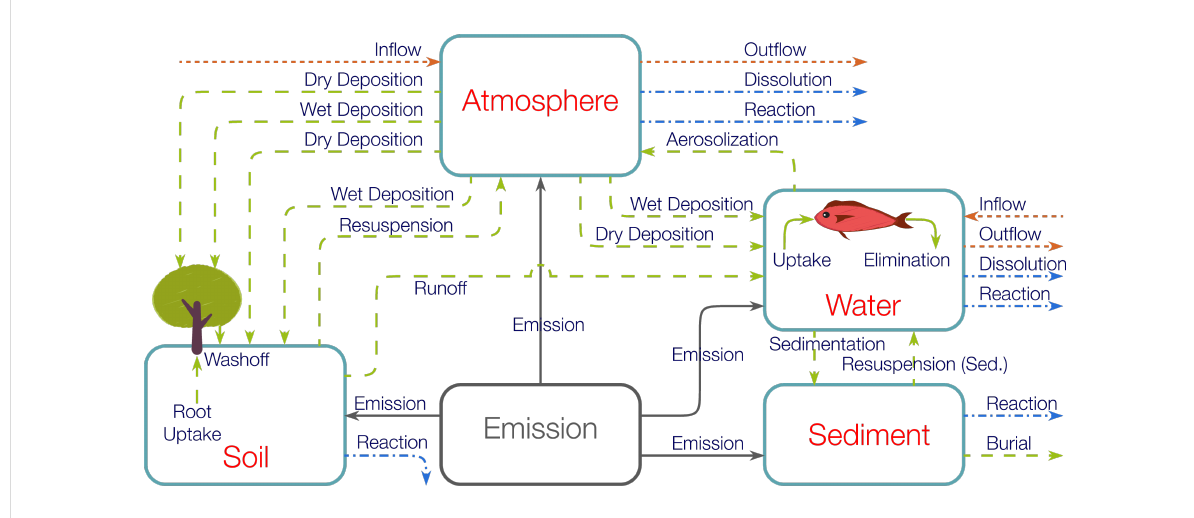
Figure 2: Transport processes in MendNano. Green dashed lines represent intermedia transport processes, blue dash-dot lines represent reactions (including dissolution) within the compartments that eliminate the ENM from particle phase, orange dotted lines represent advection (i.e., transport of ENMs via the flow of air and water) into and out of the given compartment, and gray solid lines represent emissions (i.e., ENM release events into the